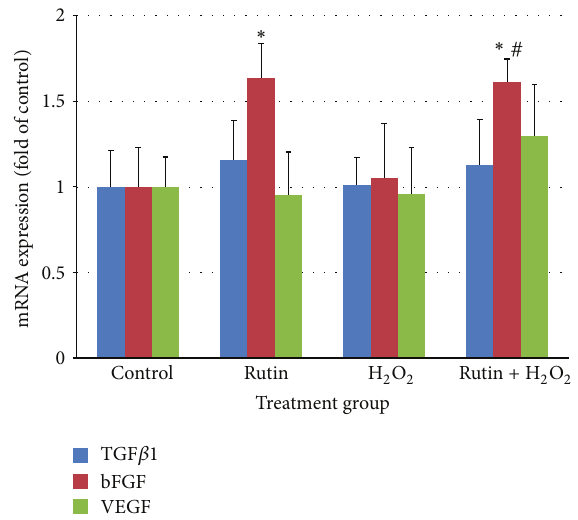
Figure 5: Bar chart showing TGF 𝛽 1, bFGF, and VEGF mRNA expression in control, rutin, H 2 O 2 , and rutin + H 2 O 2 groups. Values are expressed as means ± SEM of 𝑛 = 8 . ∗ 𝑃 < 0.05 versus control; # 𝑃 < 0.05 versus H 2 O 2 .